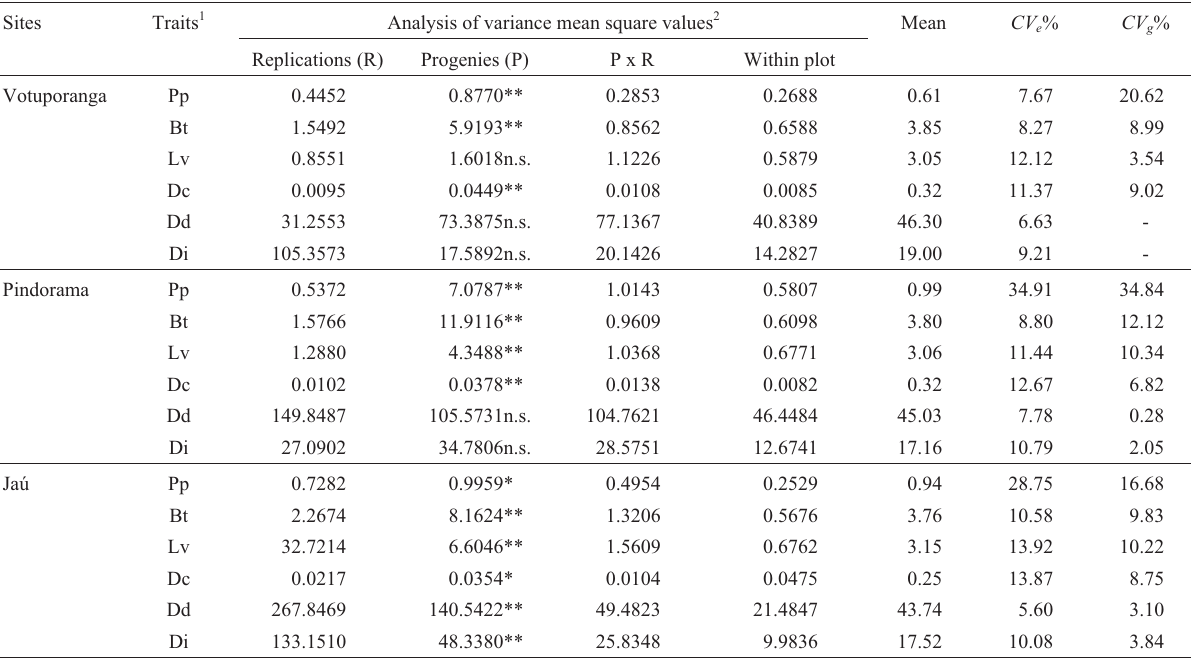
Table 1 - Mean squares, coefficient of experimental variation ( CV e %) and coefficient of genetic variation ( CV g %) for six different traits of the bark laticiferous system in 22 three-years-old open pollinated Hevea progenies growing at three sites in the Brazilian State São Paulo. Sites Traits 1